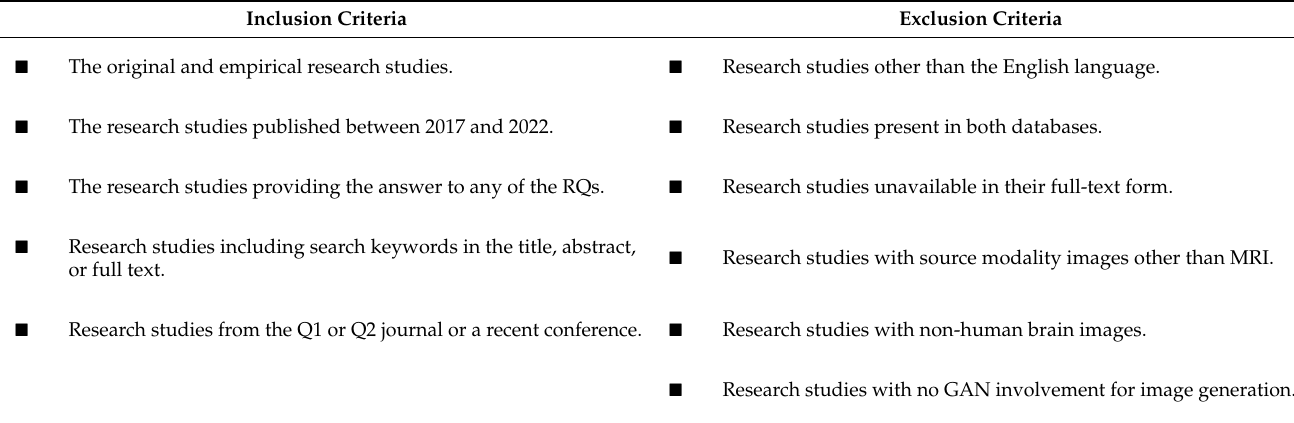
Table 4. List of inclusion and exclusion criteria.